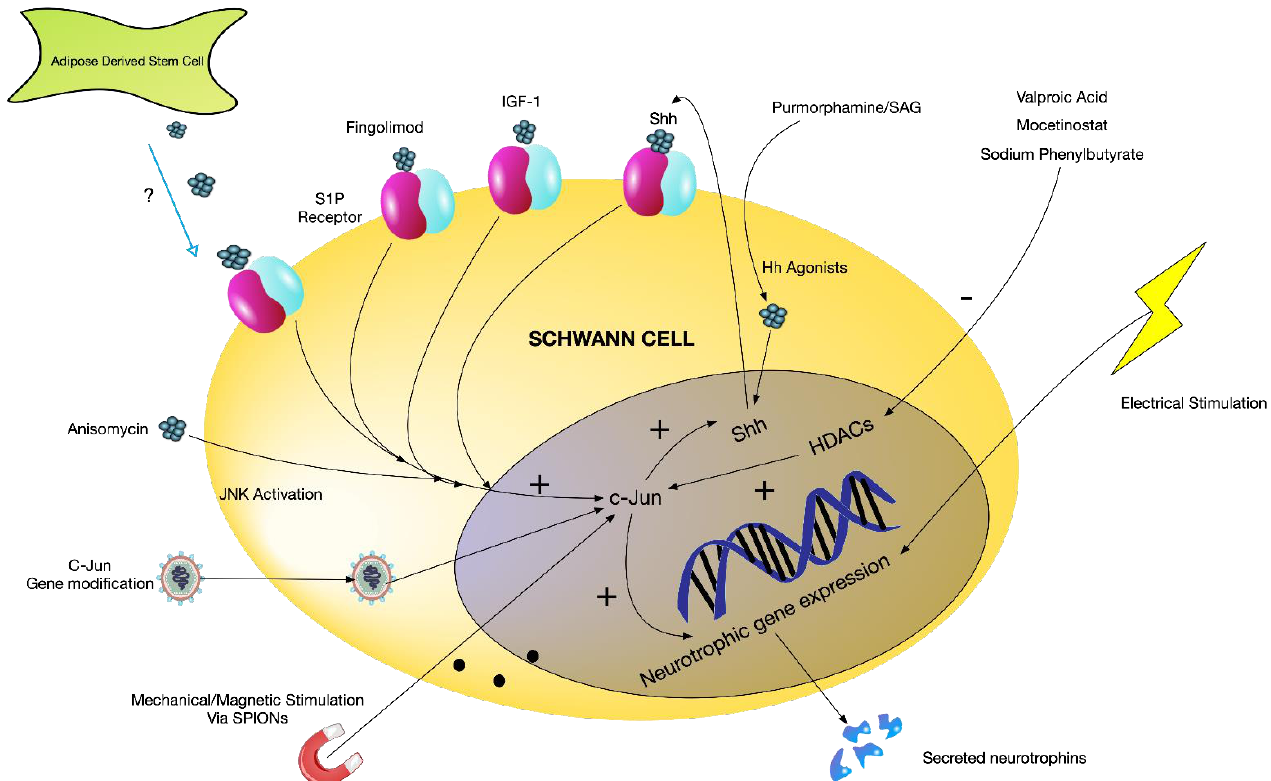
Figure 2. The identification of c-Jun as a key determinant of the denervated SC phenotype creates new routes for potential therapeutic intervention/investigation. The augmentation of c-Jun triggers paracrine and autocrine loops (e.g., Shh activation) that further maintain the rSC phenotype (leading to neurotrophin secretion and morphological changes that aid nerve regeneration). Several pharma- ceutical agents (fingolimod/Hh agonists/Anisomycin/HDAC inhibitors) and genetic engineering strategies have been used to directly augment c-Jun and improve experimental nerve regeneration. The use of the ASC secretome, electrical and mechanical stimuli and agonists from the growth hor- mone axis also modulate the rSC phenotype (likely through the modulation of c-Jun) and have been explored to the same end.